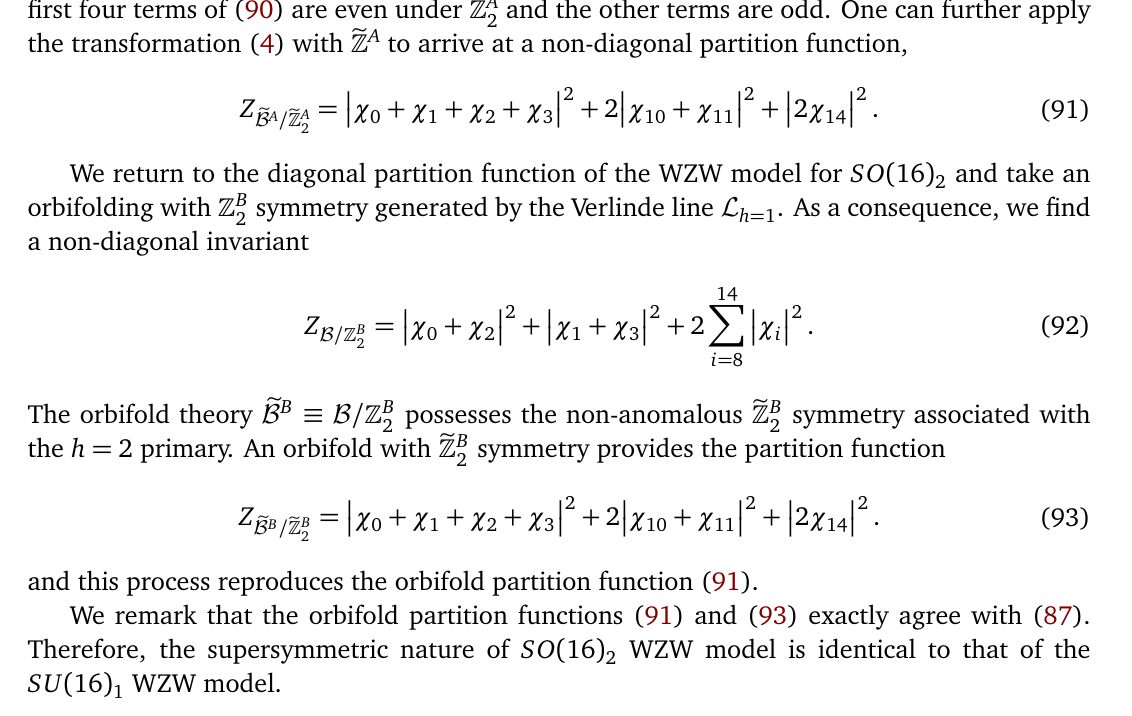
: primaries labeled by i are characterized by weights h and SO ( 16 ) Dynkin la- 2